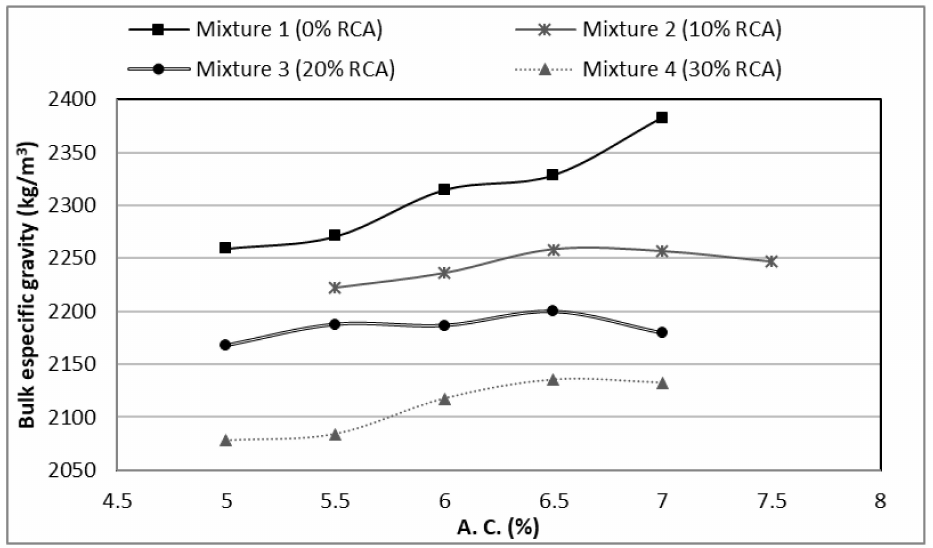
Figure 9. Specific gravity (bulk density) of the designed